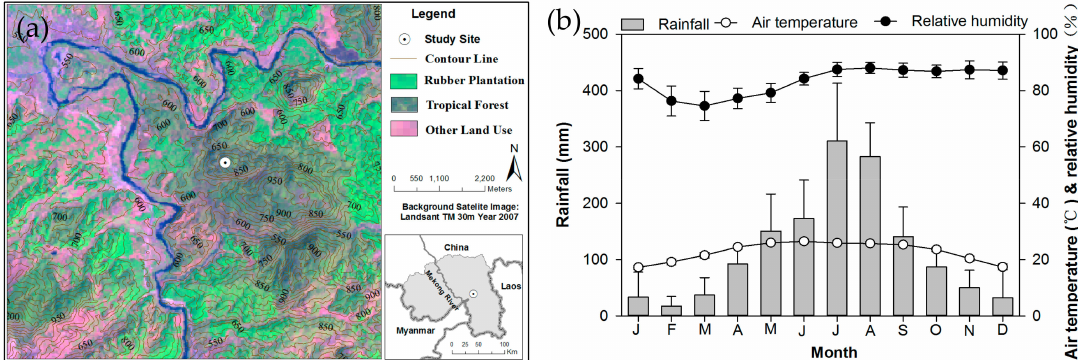
Figure 1. The location of the study site in Yunnan Province, Southwest China ( a ). Average monthly rainfall, air temperature, and relative humidity (2003–2017) recorded at a weather station ca. 4 km from the study site ( b ). Vertical crossed bar represents ± standard